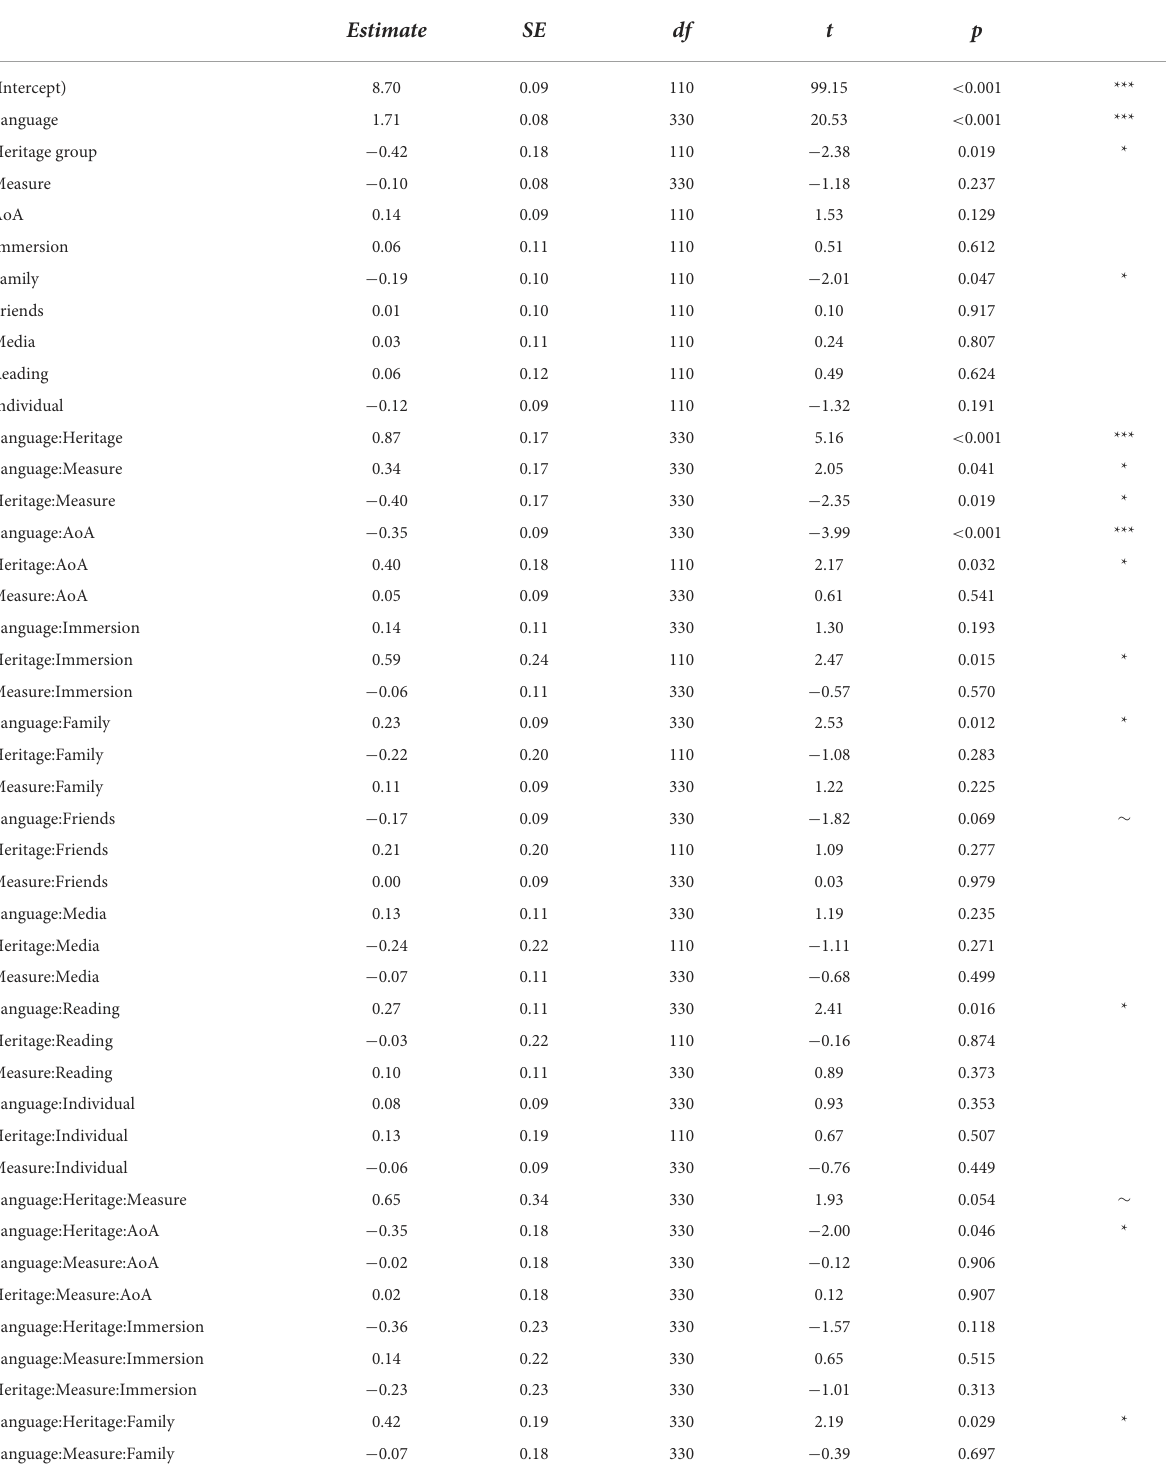
TABLE 3 Effects of English experience on self-reported heritage language and English proficiency. Estimate SE df